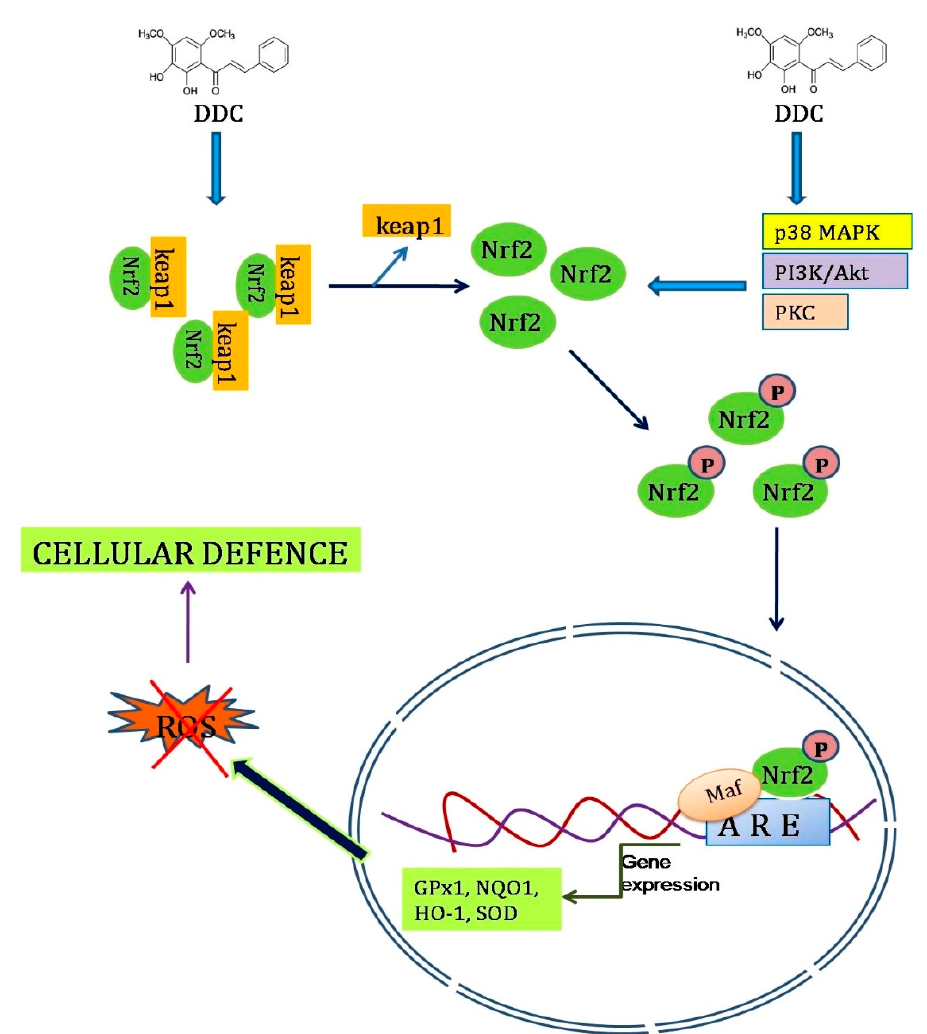
Figure 4. Schematic representation of Nrf2-ARE activation, by 2 1 ,3 1 -dihydroxy-4 1 ,6 1 -dimethoxychal- cone from P.